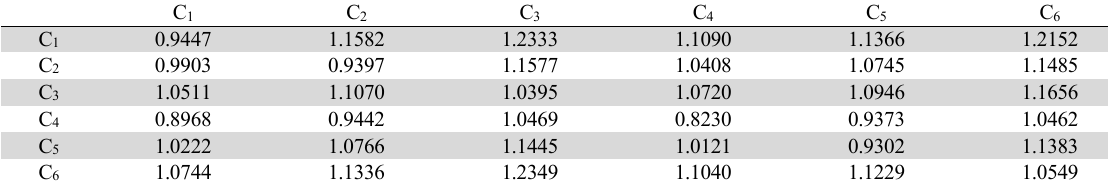
Abnormalized diaphragmatic relationships matrix